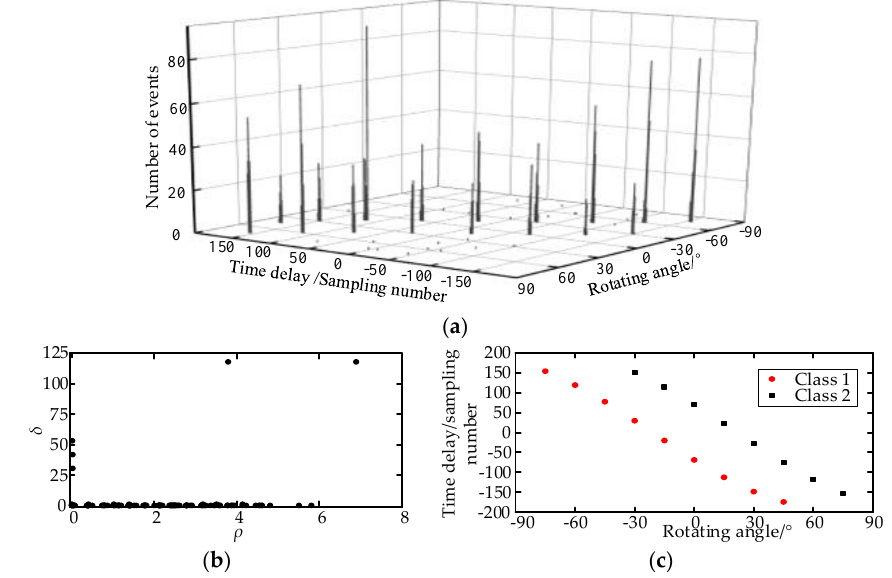
Figure 8. The TDs and decision diagram at O 2 . ( a ) The TDs at the measurement point O 2 ; ( b ) The decision diagram when α j = −30°; ( c ) The separated TD sequences at O 2 .